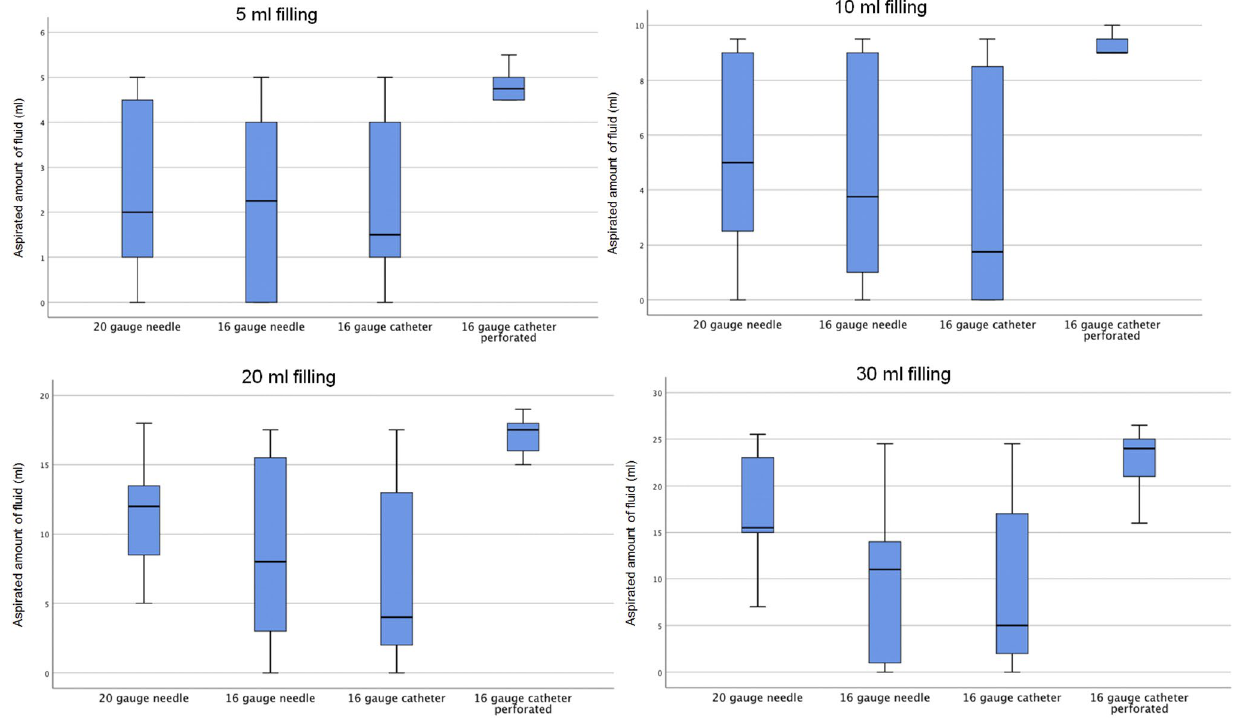
Figure 3. Comparison of aspiration devices. The amount of aspirated fluid is displayed for each needle/catheter for filling amounts of the shoulder joint of 5, 10, 20 and 30 mL. The black bold line represents the